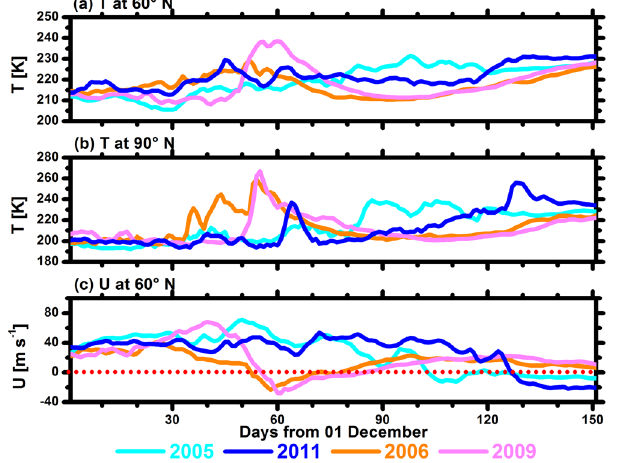
Figure 4. Time series of zonally averaged temperature (T; unit: K) and zonal wind (U; unit: m s − 1 ) from December to April in 2005, 2011, 2006, and 2009 at 10